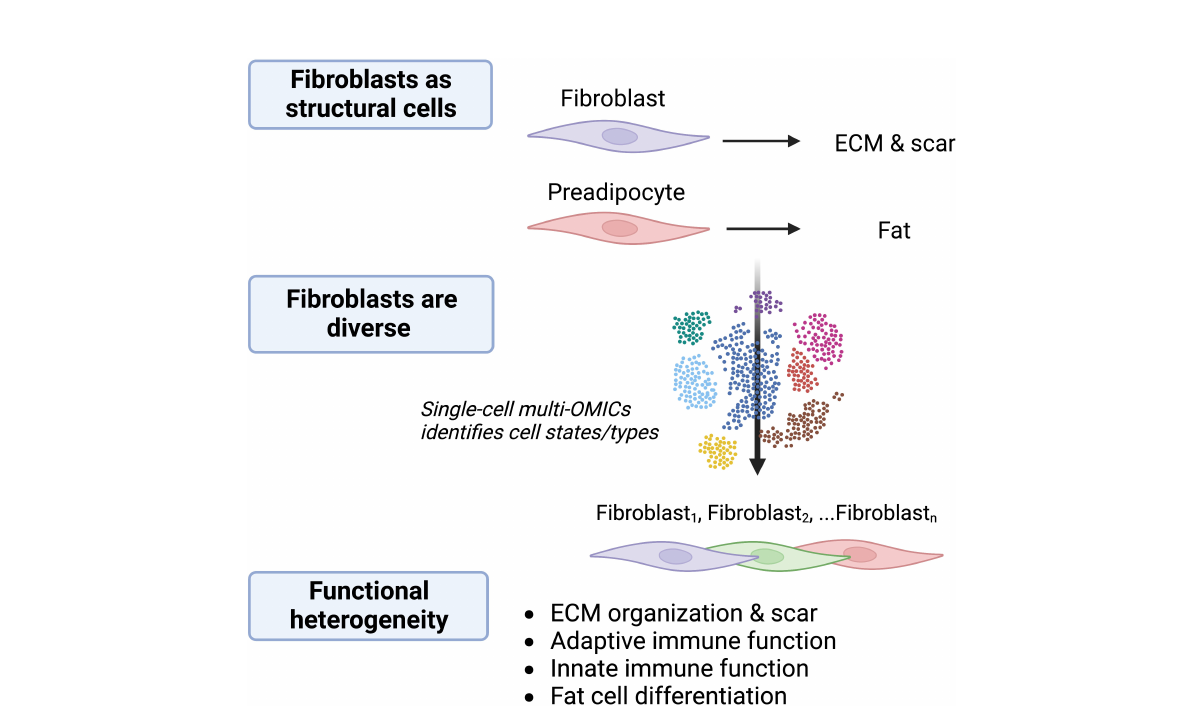
FIGURE 1 Fibroblasts are diverse and multifunctional. The understanding of cells with fi broblastic morphology is evolving. Fibroblasts were previously considered to be primarily structural cells responsible for production of ECM, acting in wound healing and fi brosis, and serving as stem cells for differentiation into structures such as fat. Single-cell multi-OMICS technology including scRNAseq has identi fi ed several fi broblast subtypes and activation states within and between tissues and disease states and revealed numerous potential distinct functions for these cells. Determining the functional signi fi cance of fi broblasts is an ongoing area of research. The choice of colors for fi broblasts illustrates that there are different functional subtypes/activation